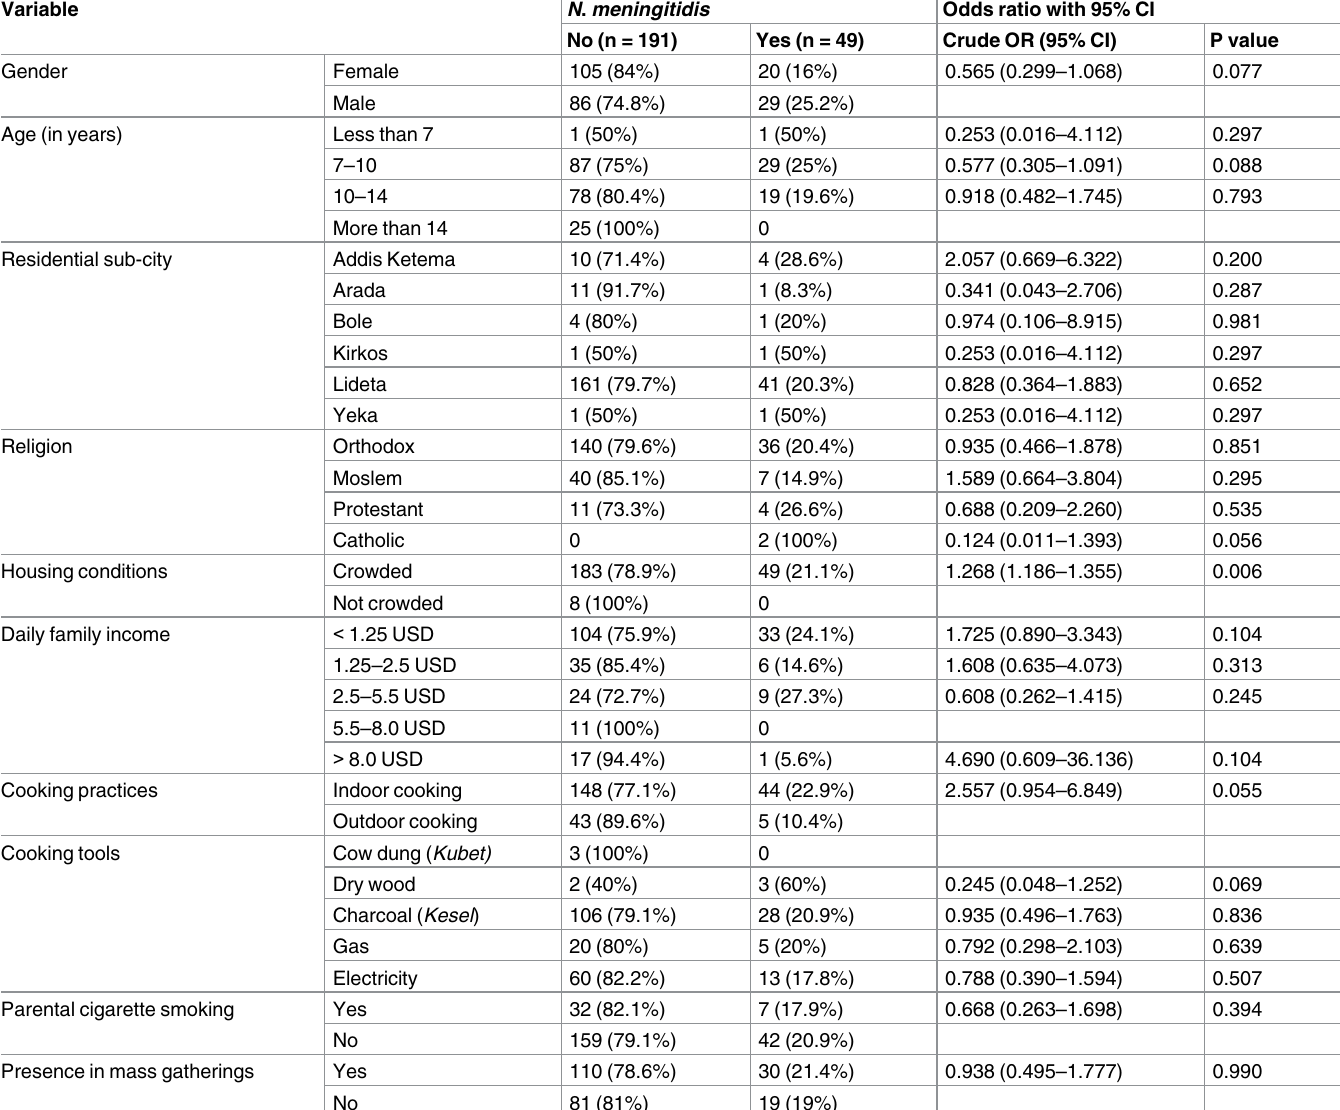
Table 3. Bivariate and multivariate analysis of risk factors for carriageamong